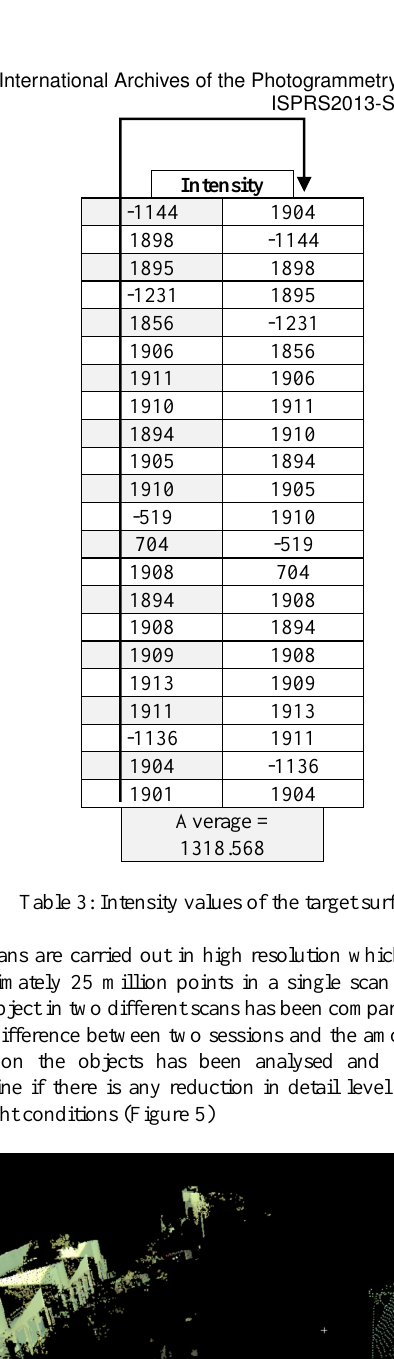
The detail count of the same object in two different lighting condition resulted that there is only %0.002 difference in detail at an object approximately 90 meters far (Figure 6).